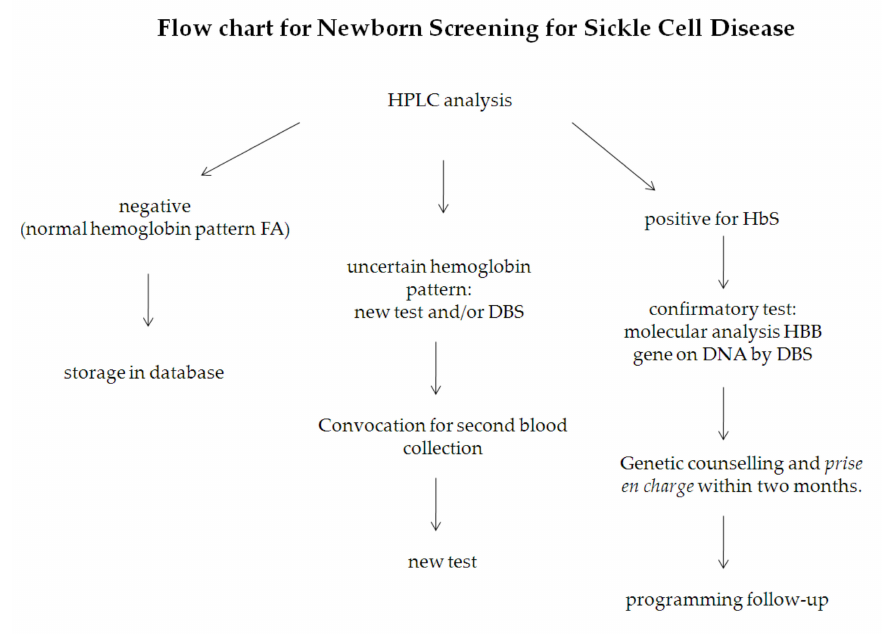
Figure 1. Flow chart for newborn screening for Sickle cell